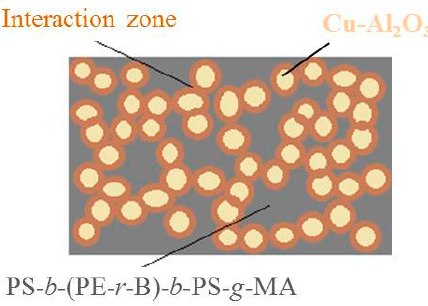
Figure 7. Schematic illustration of interaction between Cu–Al 2 O 3 conductive filler and PS- b -(PE- r -B)- b -PS- g -MA polymer matrix responsible for electron transfer.